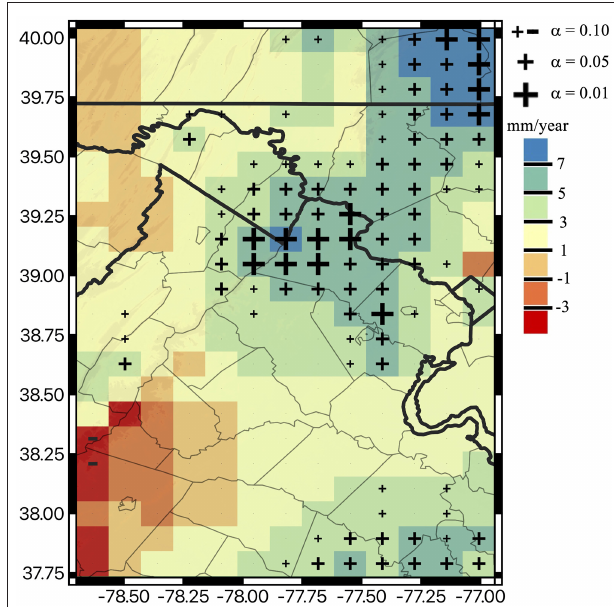
FIGURE 4 | Theil-Sen trends in annual precipitation average during 1980–2018. The size of the cross markers show the three significance levels used to perform a Mann-Kendall test on the Theil-Sen trends. Markers are not shown in grids with non-significant trends.